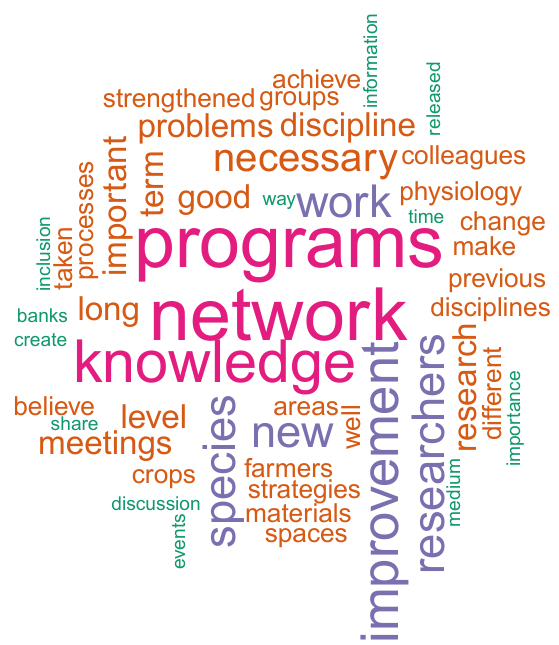
Figure 7. Graphic representation of a word cloud analysis of the 52 opinions about improving the plant breeding and plant genetic resources group in A GROSAVIA .